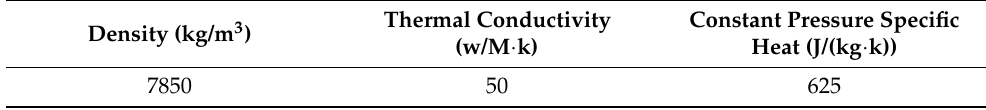
Table 3. Physical parameters of 20 G.